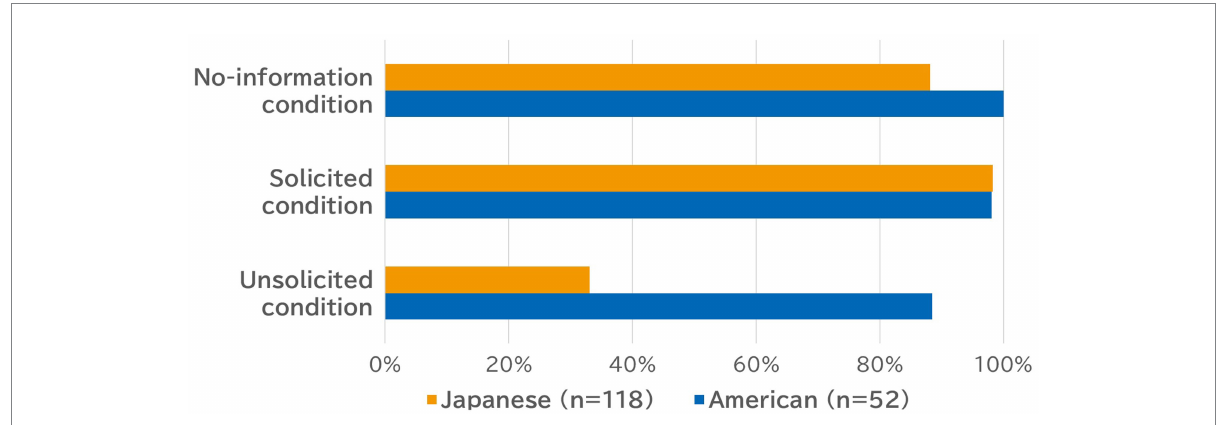
FIGURE 2 Provision rate of solicited and unsolicited social support among Japanese and American